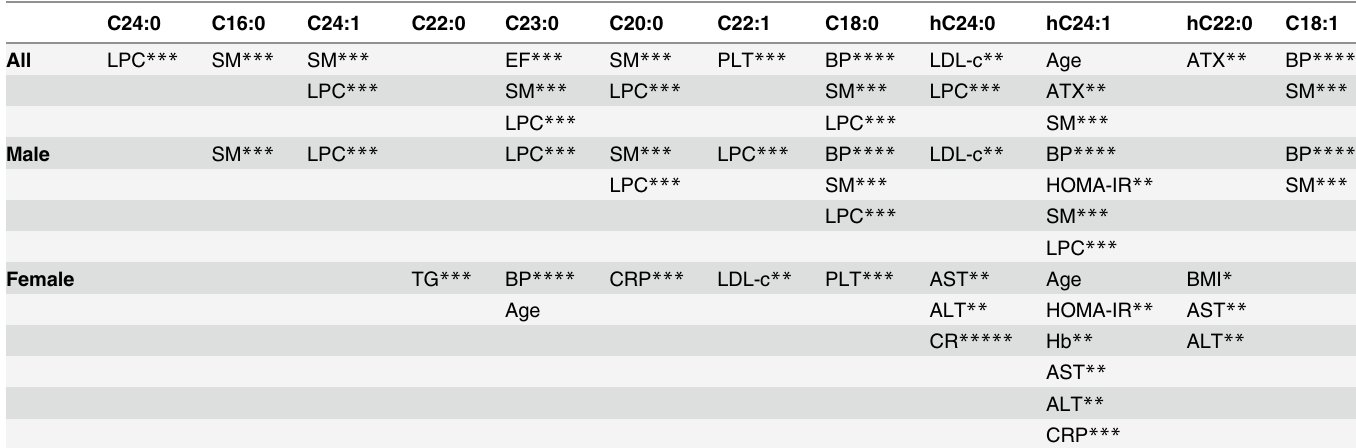
Table 2. Serum GM3 Molecular Species Multivariate